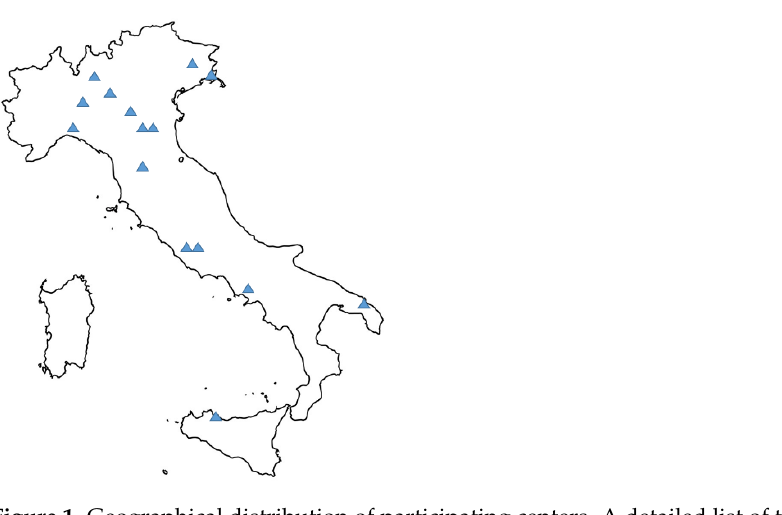
Figure 1. Geographical distribution of participating centers. A detailed list of the 15 participating centers is available as Supplementary Material (Table S1).